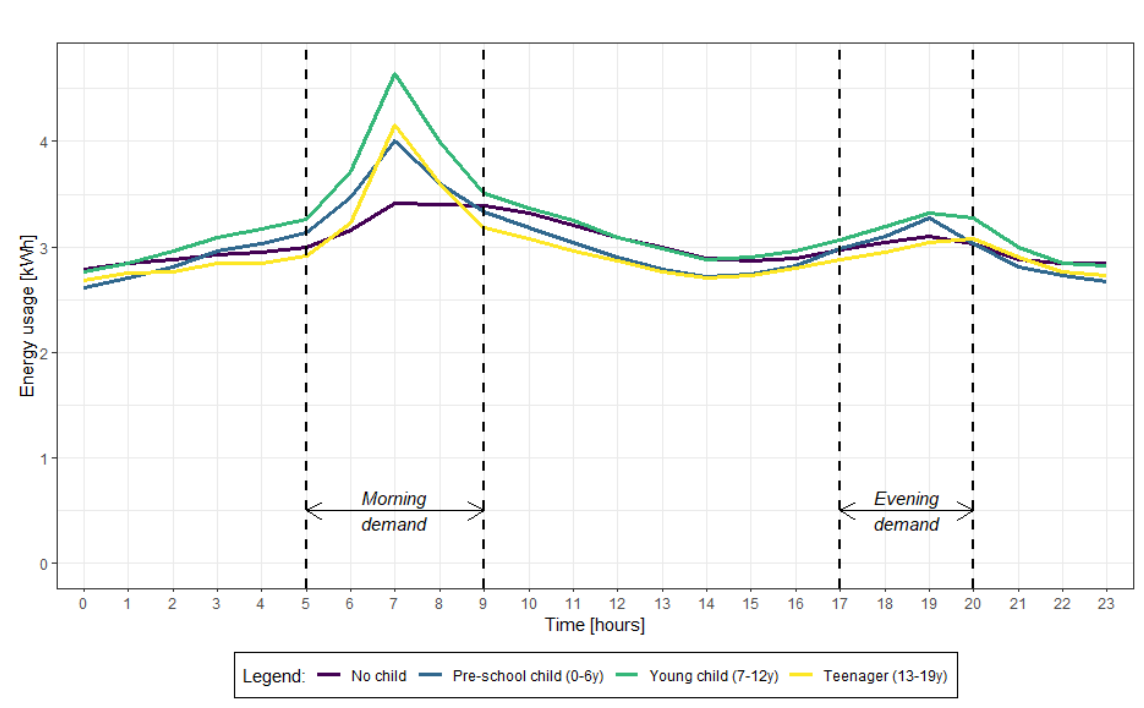
Figure 6. Heat usage profile for an average day for groups comparing the age of children based on the youngest child in households based on average hourly consumption. N = 2,005,091; n = 803.